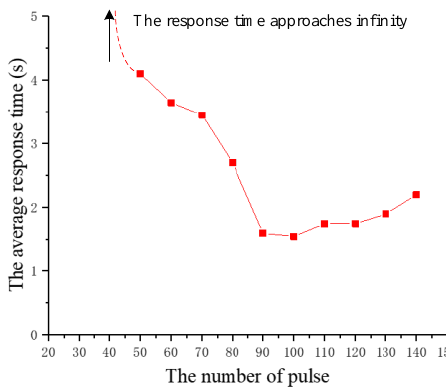
Figure 9. The relationship between the response time of beetles and the number of pulses. ( a ) The first beetle; ( b ) the second beetle.